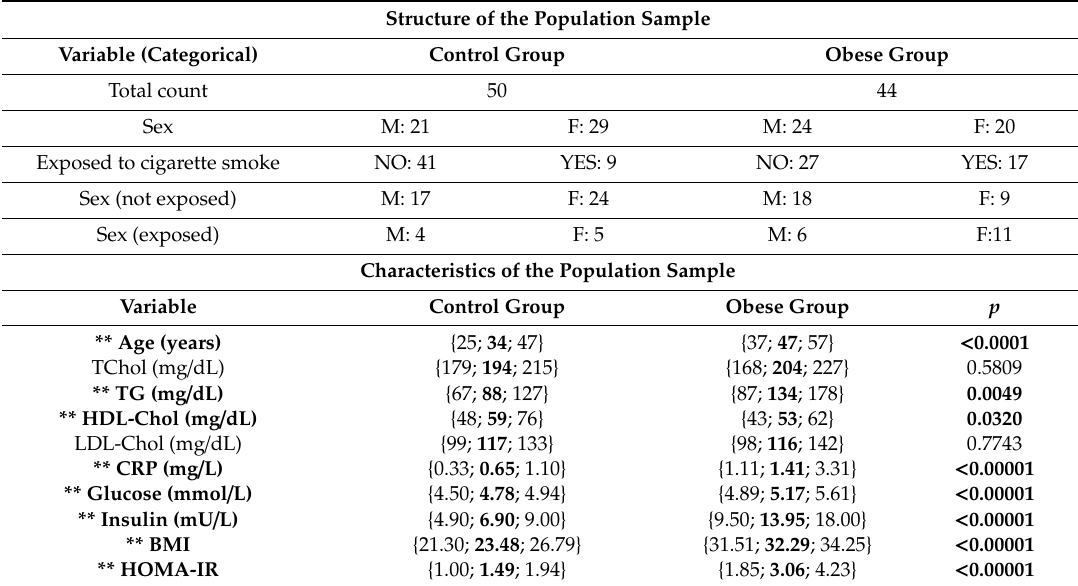
Table 13. The structure and characteristics of groups: control and